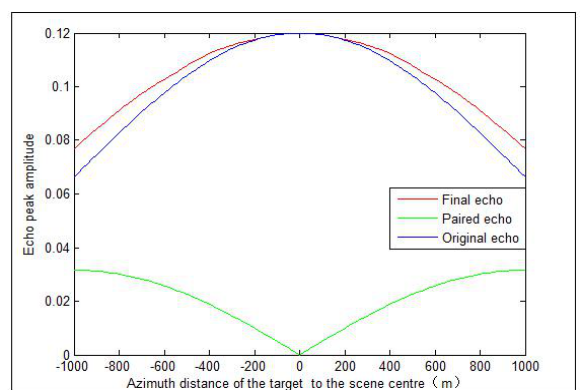
Figure 4. The influence of target azimuth direction position to the echo peak amplitude When the target location of azimuth direction gets away from the centre (0, ) Y , the peak amplitude of the original echo c